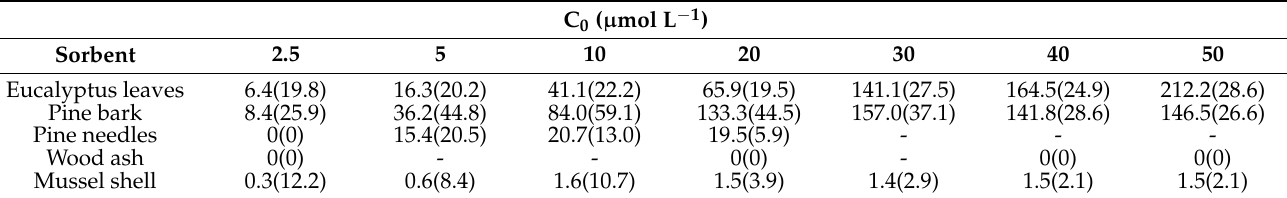
correspond to the presence of higher contents of noncrystalline Al and/or Fe compounds (Al o , Fe o ) in these bio-adsorbents (Table 1). Table 3. CFX desorption, expressed in µ mol kg − 1 (and in a percentage, between brackets), for the five different sorbents, as a function of the concentration of antibiotic added (C 0 , in µ mol L − 1 ). -: no data. Average values ( n = 3), with coefficients of variation always